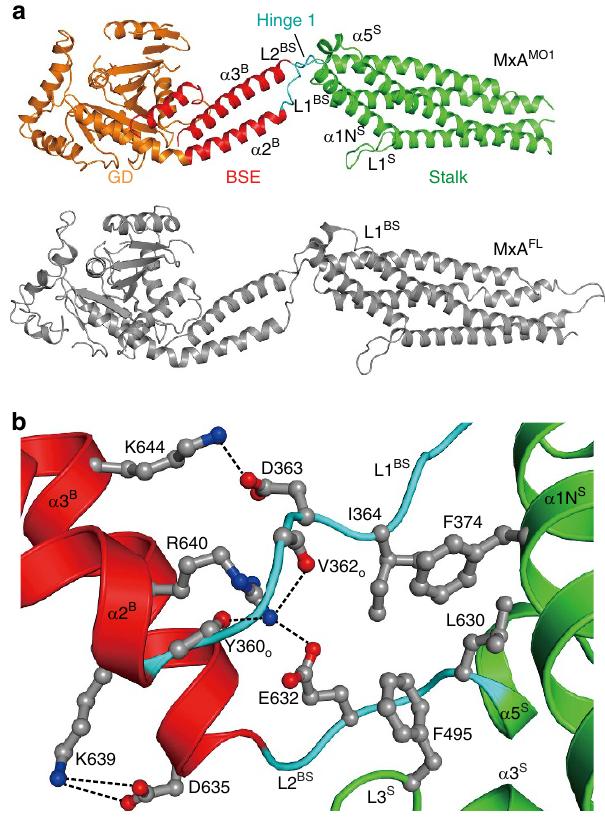
Figure 1 | Crystal structure of MxA MO1 . ( a ) Structural comparison between MxA MO1 (upper) and MxA FL (lower, PDB accession number 3SZR). For MxA MO1 , GD, BSE, stalk and hinge 1 are coloured orange, red, green and cyan, respectively. Secondary structure elements surrounding hinge 1 are indicated. MxA FL is coloured grey. ( b ) Associations of hinge 1 with the BSE and stalk. Involved residues are shown in ball-and-stick representation. Domains are coloured as in a